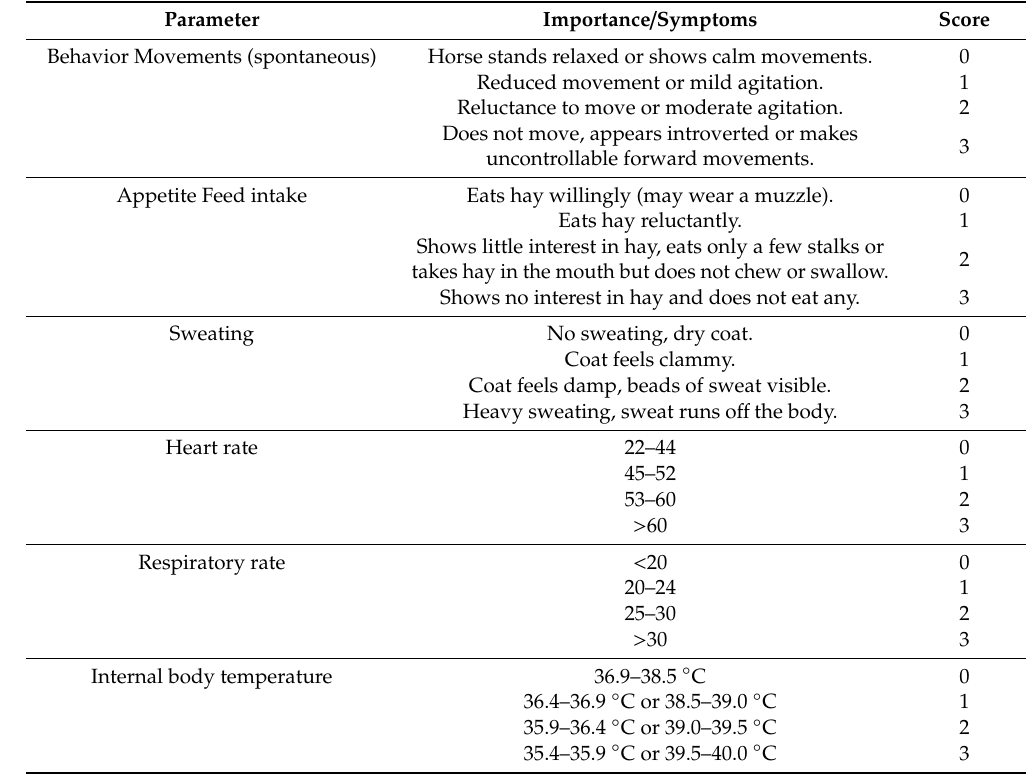
Table 1. Pain scale to determine the intensity of the pain. General Part.